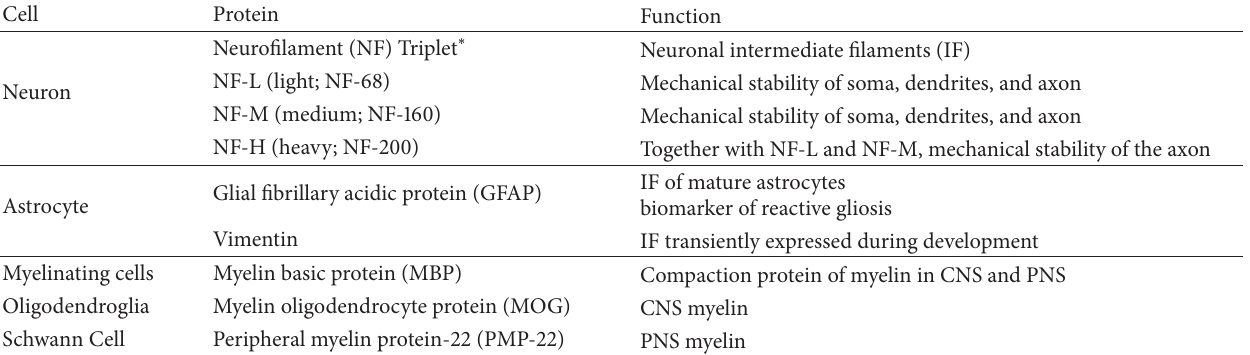
Table 2: Protein antigens, their cellular source, and